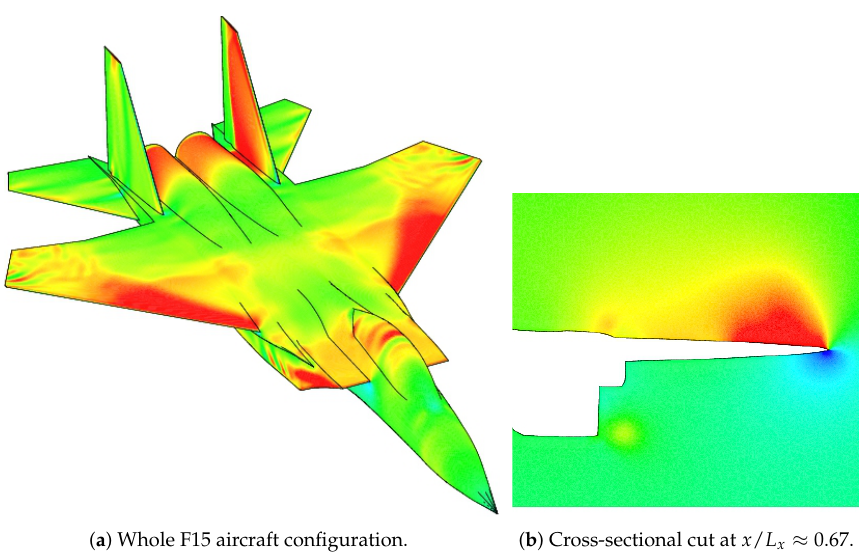
Figure 13. Iso-contours of the pressure coefficient in the F15 aircraft configuration ( C p range of color contour as in Figure 14).